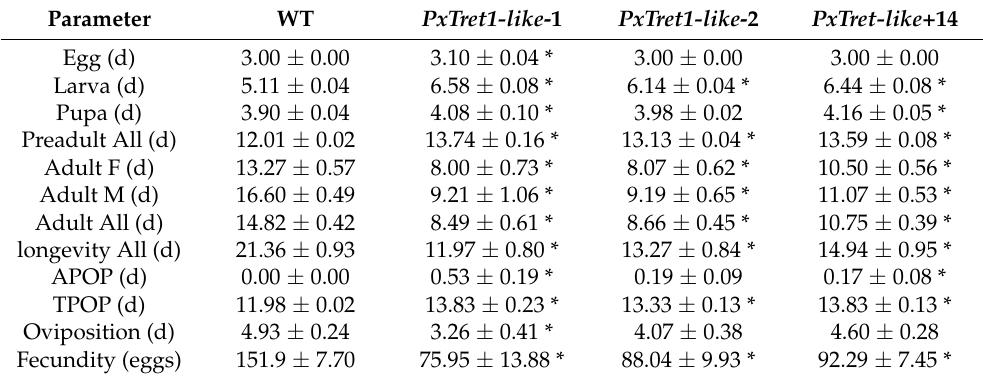
Table 1. Developmental time, longevity, APOP, TPOP, fecundity, and Oviposition on different PxTret1-like mutants and wild-type strain in different generations.